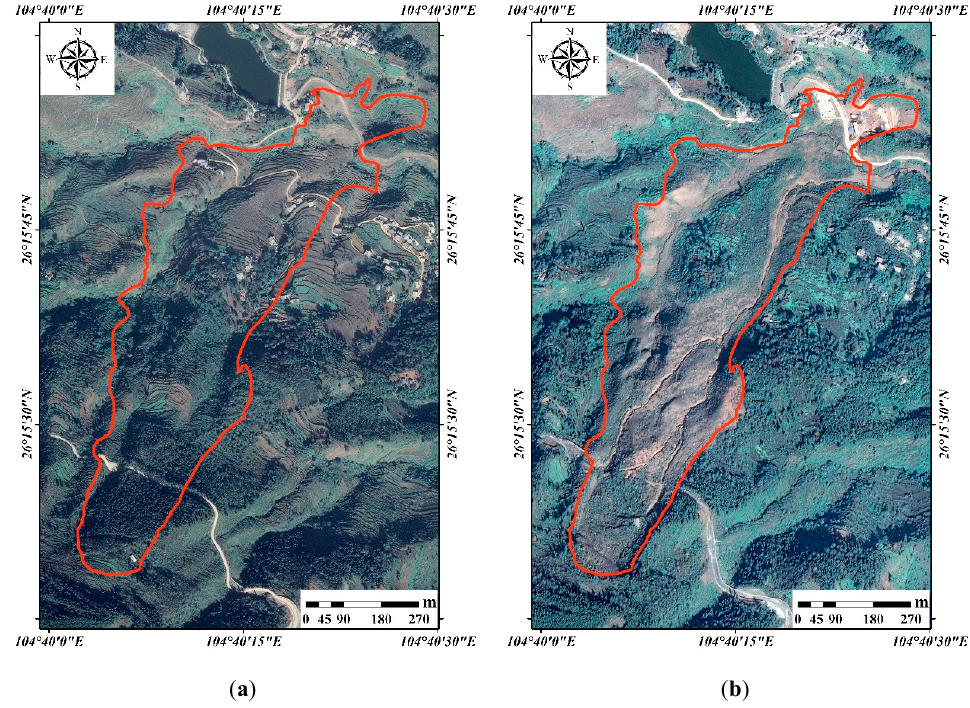
Figure 2. Pre-sliding and post-sliding Google Earth satellite maps of the Jichang landslide: ( a ) before the slide (14 November 2018) and ( b ) aerial image after the slide (11 November 2020).